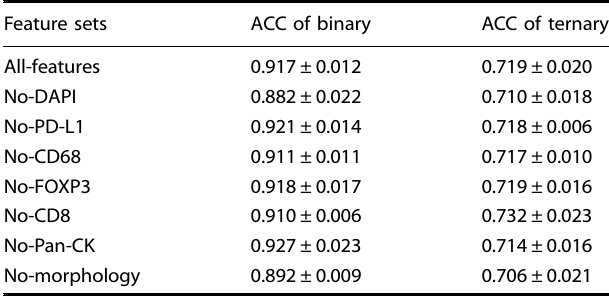
Table 2. Ablation studies of the major types of features used by the GNN models in both binary and ternary classi fi